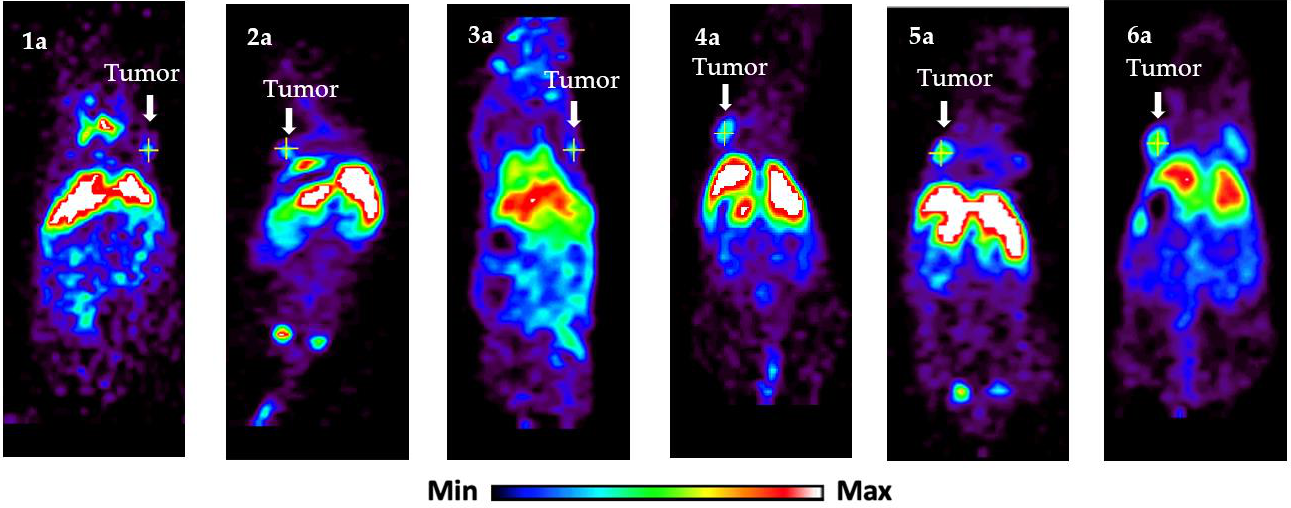
Figure 2. Representative whole-body coronal PET images of tumor-bearing mice at 22 hrs post-injection of PEG-RGD-AuNP conjugate 1 ( 1a ), PEG-MTX-AuNP conjugate 2 ( 2a ), PEG-Glu-AuNP conjugate 3 ( 3a ), MTX-RGD-AuNP conjugate 4 ( 4a ); Glu-RGD-AuNP conjugate 5 ( 5a ), Glu-MTX- AuNP conjugate 6 ( 6a ). Each image was scaled to best show the tumor. No quantitative intercompari- son should be made between images. The images provide a comparison of relative intensity between tumor and muscle (see Table 3 for ratios).